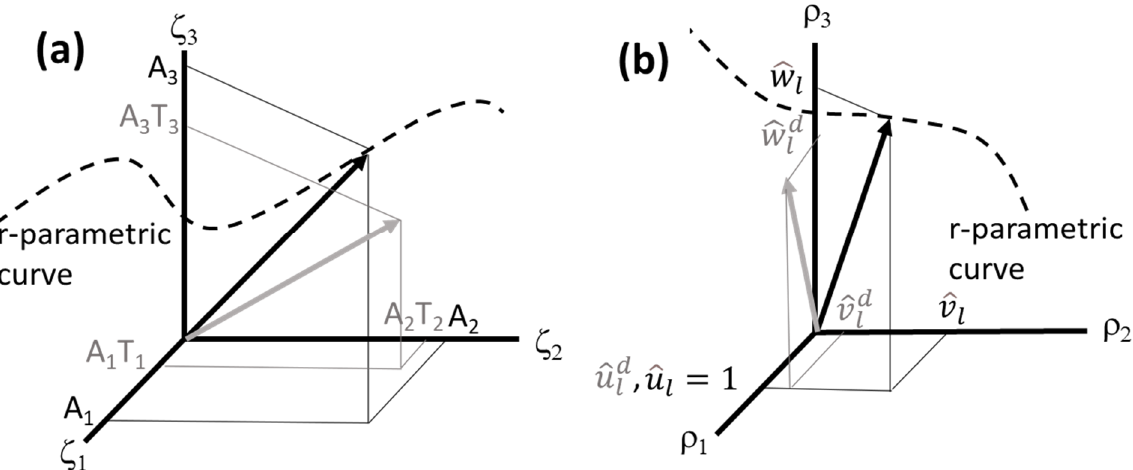
Figure 8. Navigating the state spaces, ( a ) H S and ( b ) H R by varying the driving parameter r . The state vector in absence of defects, represented by a solid arrow, is given by ( a ) a coherent superposition of product states with basis ζ 1 , ζ 2 , and ζ 3 i.e., Equation (14) and ( b ) the corresponding representation in the space of rods in the basis ρ 1 , ρ 2 and ρ 3 i.e., Equation (43) The locus of points spanned by the state vector of the undefected and defected systems as r is varied are shown as dashed lines. The state of the transmitted wave in both systems corresponding to the same r as that of black arrows are represented as grey arrows. The grey arrow spans another r -parametric curve (not drawn). The components of the state vectors for the defected system are labelled in grey with an upper script d for ( b ).